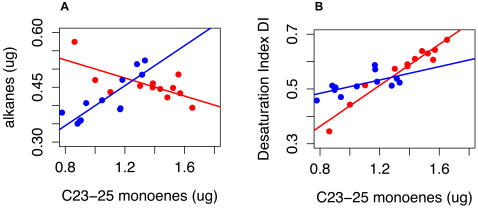
Effect of LD AV variation at CT13.(A) n-alkanes versus monoenes (B) Desaturation Index DI versus monoenes. (A) Sum of n-alkanes versus sum of C23–C25 monoenes, in LD. Non-normalized data is used. Red, CT 13; blue, CT14. Slope for CT13 differs significantly from CT 14 and other hours (p<2e-5) (CT 13, slope −0.12±0.04; CT 14 slope 0.27±0.05; other hours, 0.19±0.01). Compare with Figure 10 (a), AV by hour in LD, where a peak in monoene AV occurs at CT 13 and a minimum at CT 14. (B) The Desaturation Index (DI[33]) calculated for the same flies. Slope for DI versus total monoenes – CT 13: 0.374±.0295; CT 14: 0.122±.0468; other hours: 0.113±.00828. CT 13 slope differs from other hours (p = 5e-06).